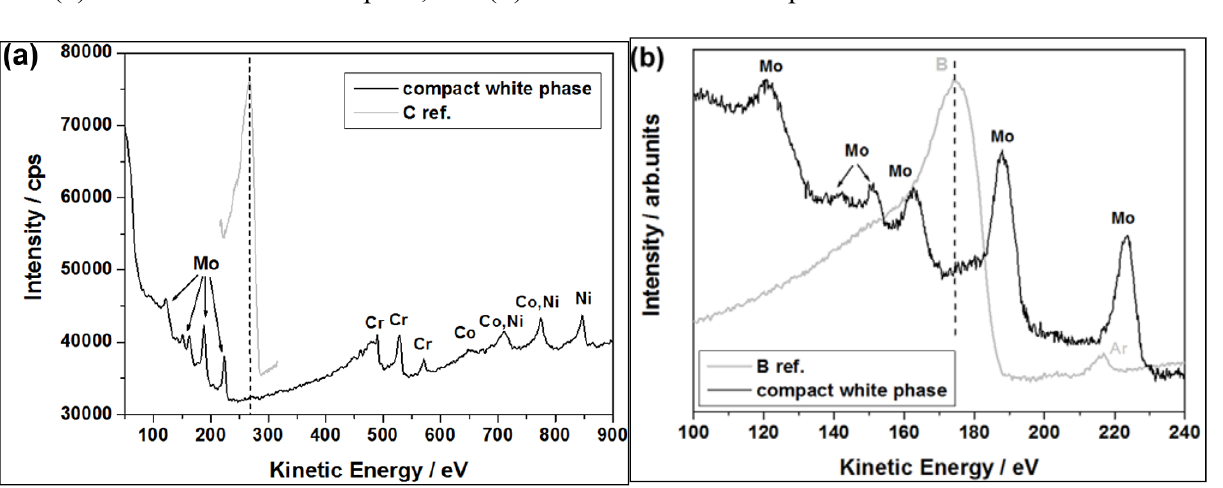
Figure 8. Local auger electron spectroscopy (AES) spectra for the compact “white phase” ( a ) with reference carbon peak; and ( b ) with reference boron